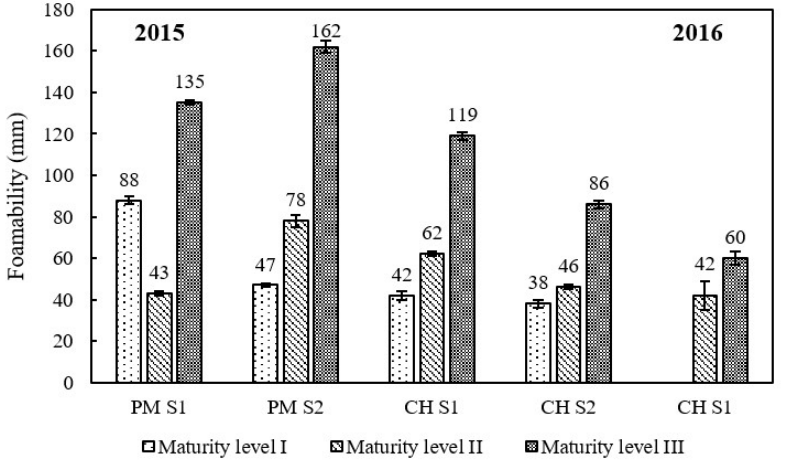
Figure 4. Foamability of Pinot meunier (PM) and Chardonnay (CH) base wines in vintages 2015 and 2016. Error bars represent the standard deviation of three replicates .